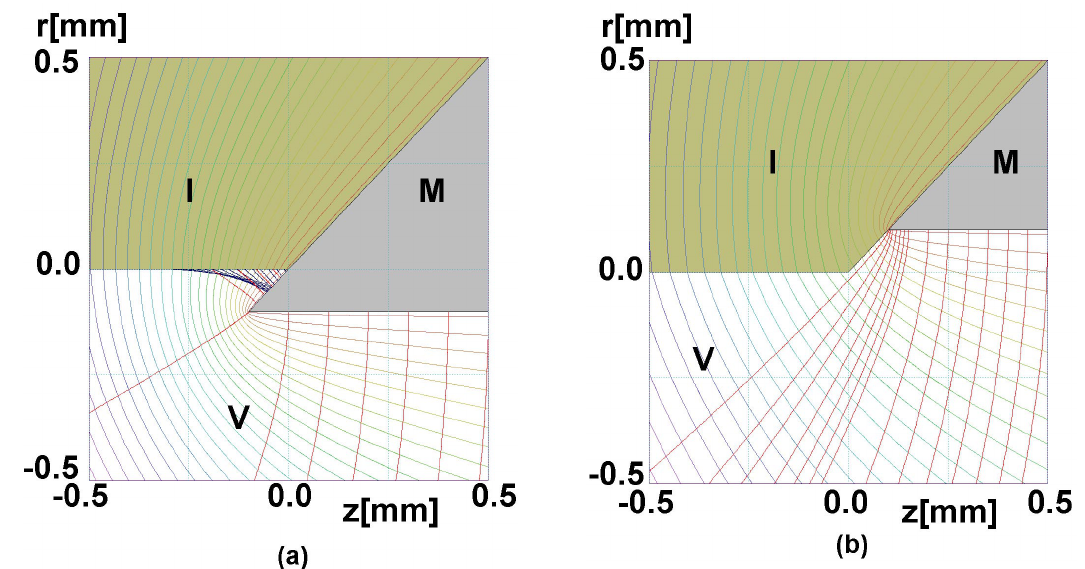
FIG. 19. (Color) Same as Figs. 17 and 18 but for the anode field-shaping ring. Positive ion trajectories are drawn as red curves in the